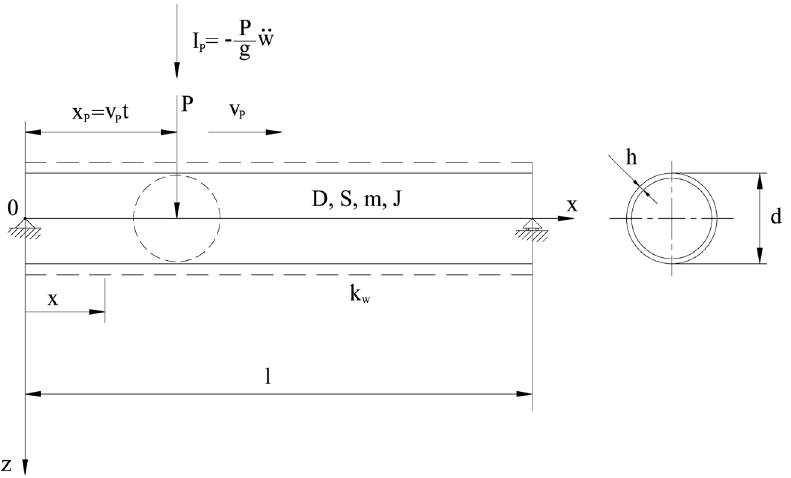
Figure 2 Carbon nanotube embedded in elastic medium exposed to gravity and inertia force of moving